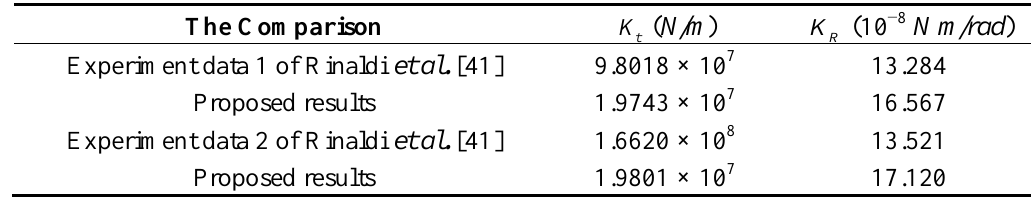
Table 2. The comparison of the equivalent stiffness between the proposed results and the reported experimental data